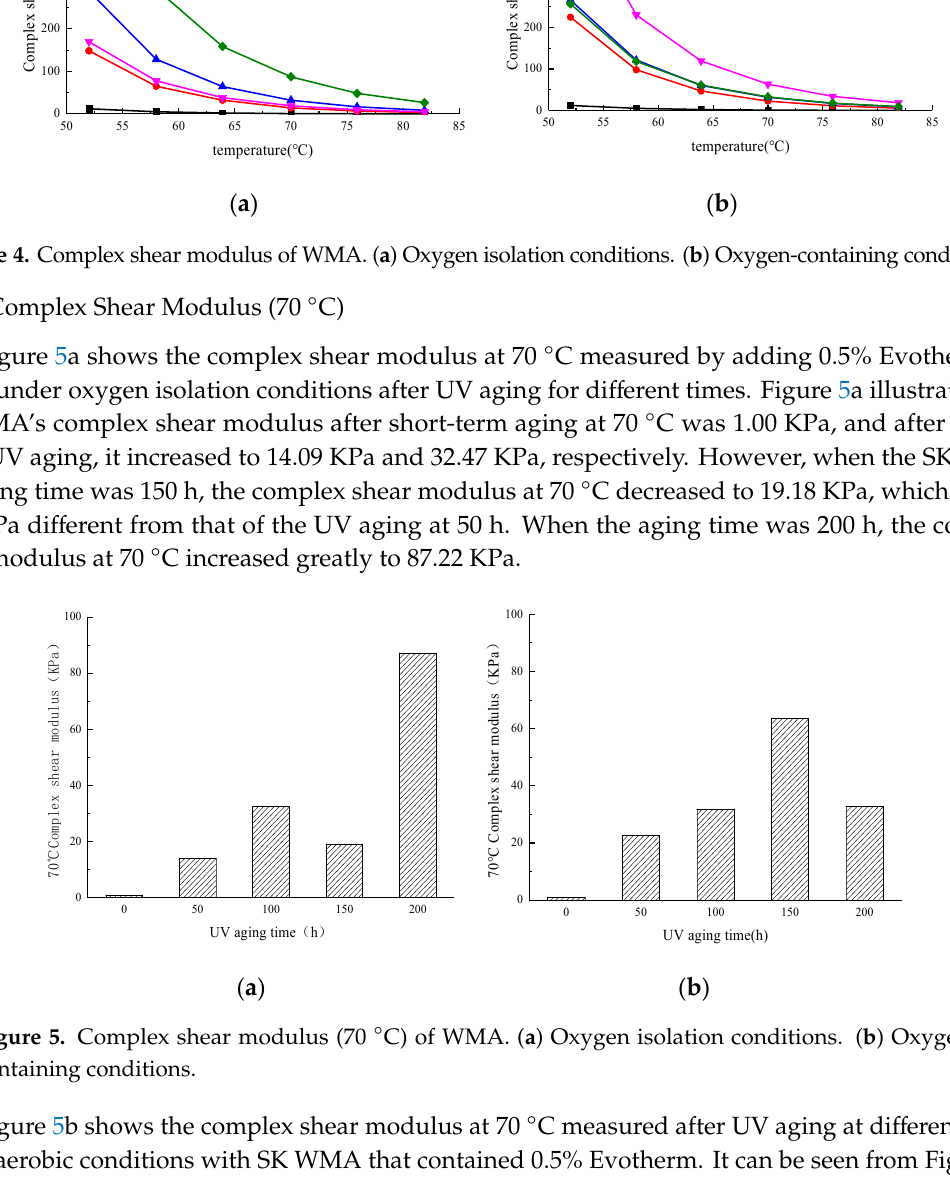
Figure 4. Complex shear modulus of WMA. ( a ) Oxygen isolation conditions. ( b ) Oxygen ‐ containing conditions.